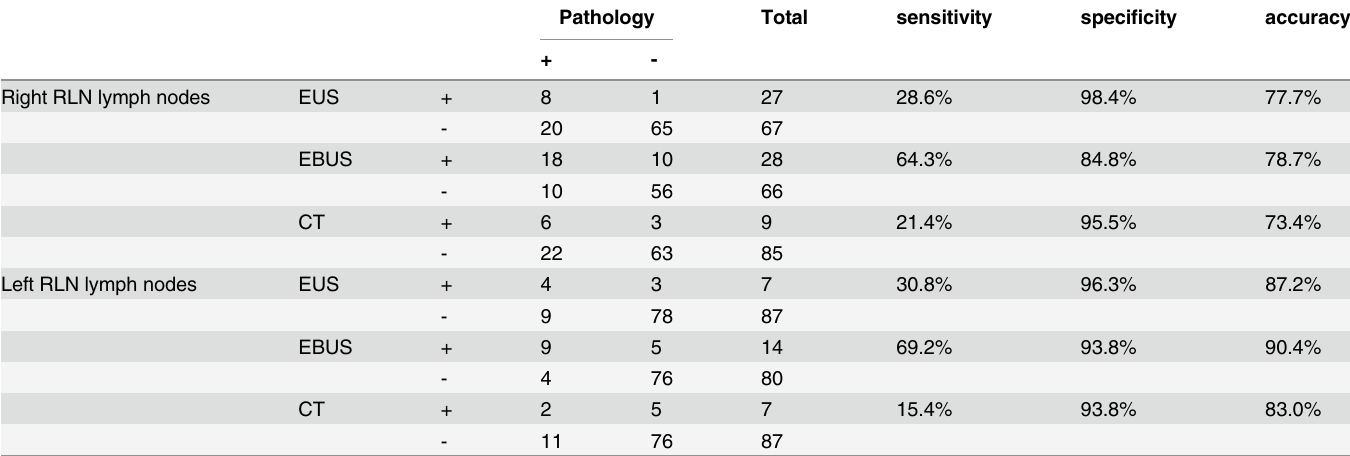
Table 4. The effect of positions on accuracy by EUS, EBUS and CT in the diagnosis of RLN lymph node metastases.